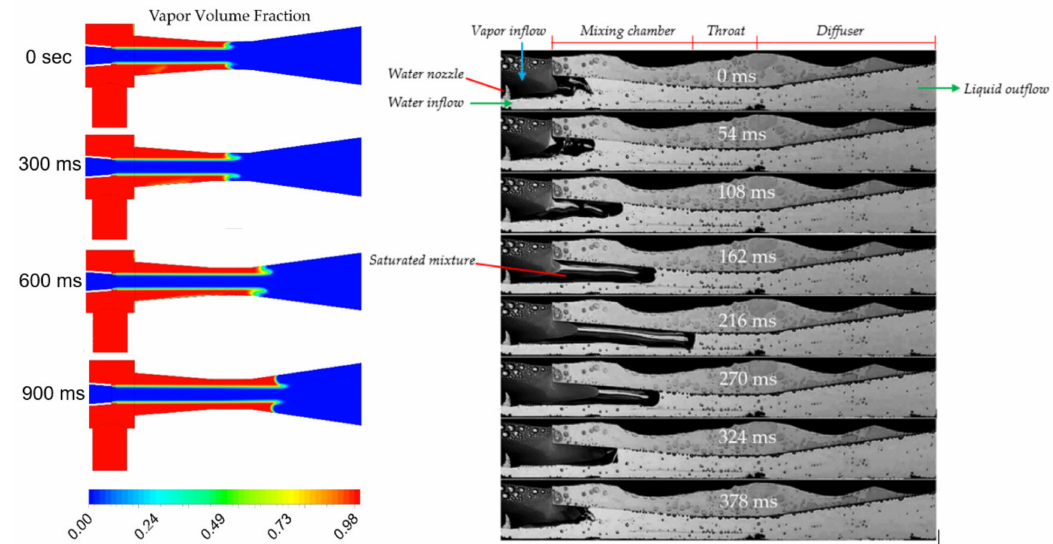
Figure 9. Visual verification of computational method.